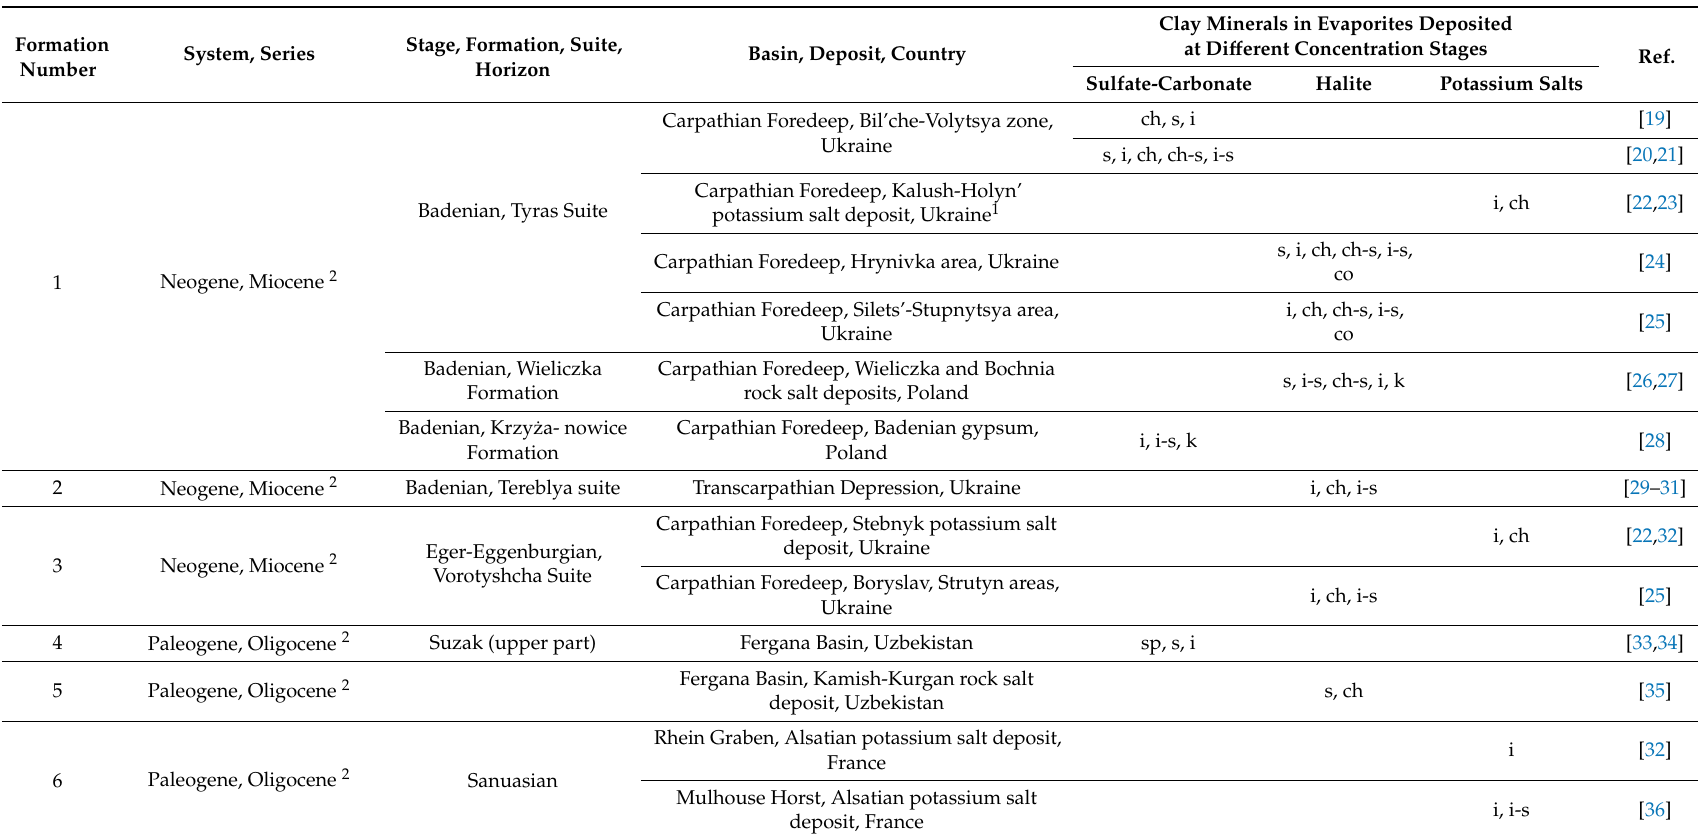
Table 1. Clay mineral association in Phanerozoic marine evaporite formations were analysed in this study. Minerals: ch—chlorite, ch*—swelling